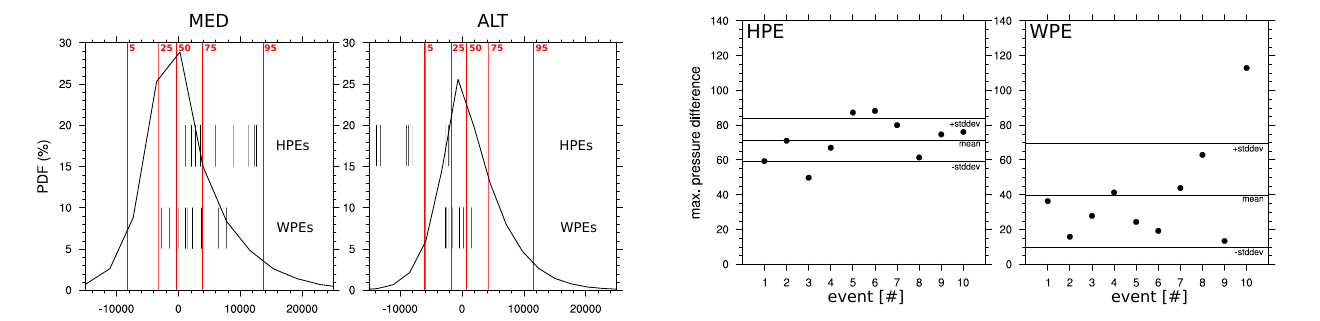
Figure 7. Probability density function of the accumulated moisture flux of all Vb events (black line). The vertical top (bottom) lines indicate the accumulated moisture flux of the HPEs (WPEs) through the stippled black lines depicted in Fig. 2 labelled with “MED” (left panel) and labelled with “ATL” (right panel). The red lines indicate the 5, 25, 50, 75 and 95 percentile from left to right.